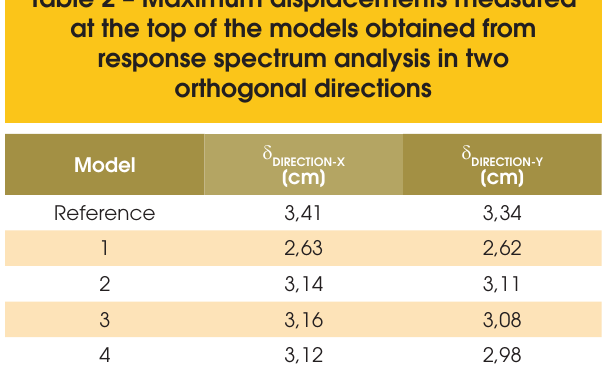
Table 2 – Maximum displacements measured at the top of the models obtained from response spectrum analysis in